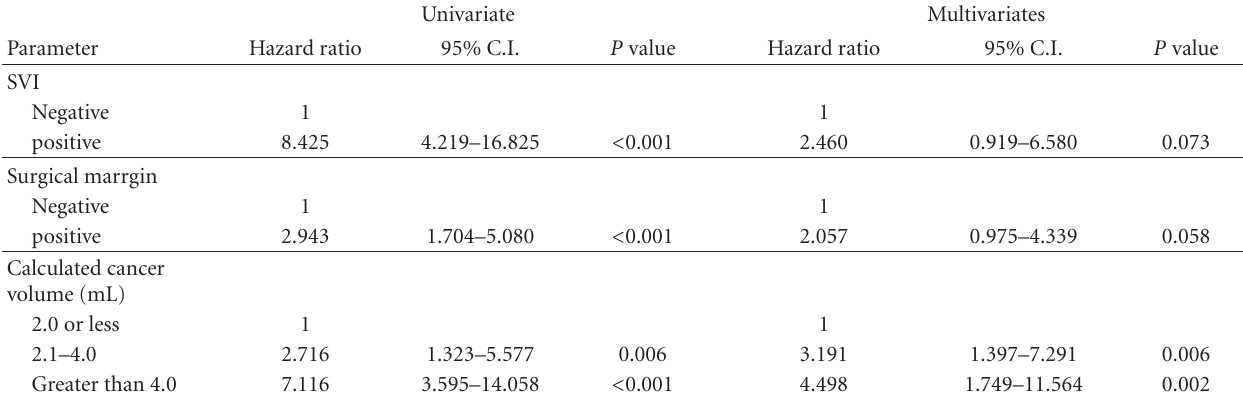
Table 5: Univariate and multivariate analysis in both preoperative and postoperative clinicopathological parameters. Univariate